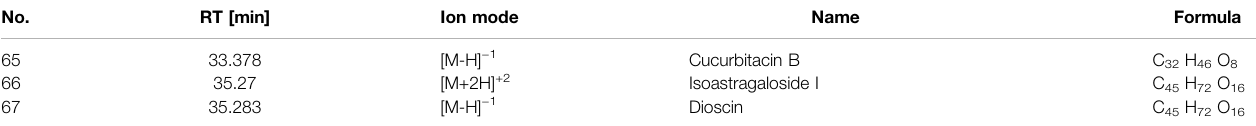
TABLE 1 | ( Continued ) Information of compounds of compatibility of AMD and RTD with a ratio of 5 to 3 detected by LC-ESI-MS/MS in different Ion modes. No.